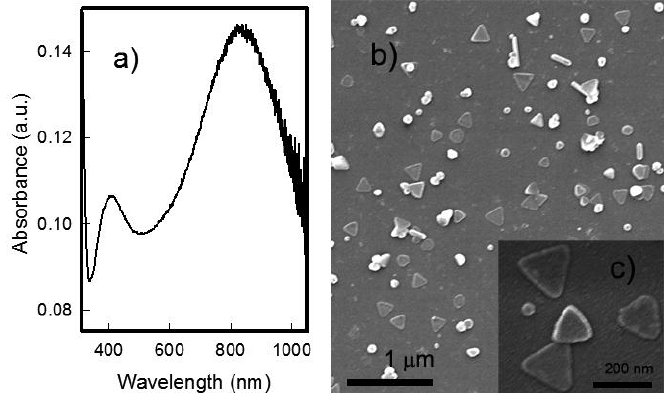
Figure 2. ( a ) UV–vis spectra of a GLASS-PEI-TRI sample; ( b ) Scanning electron microscope (SEM) image of a GLASS-PEI-TRI sample; ( c ) detail of a high magnification SEM image showing the presence of triangular nanoplates on the GLASS-PEI-TRI samples.